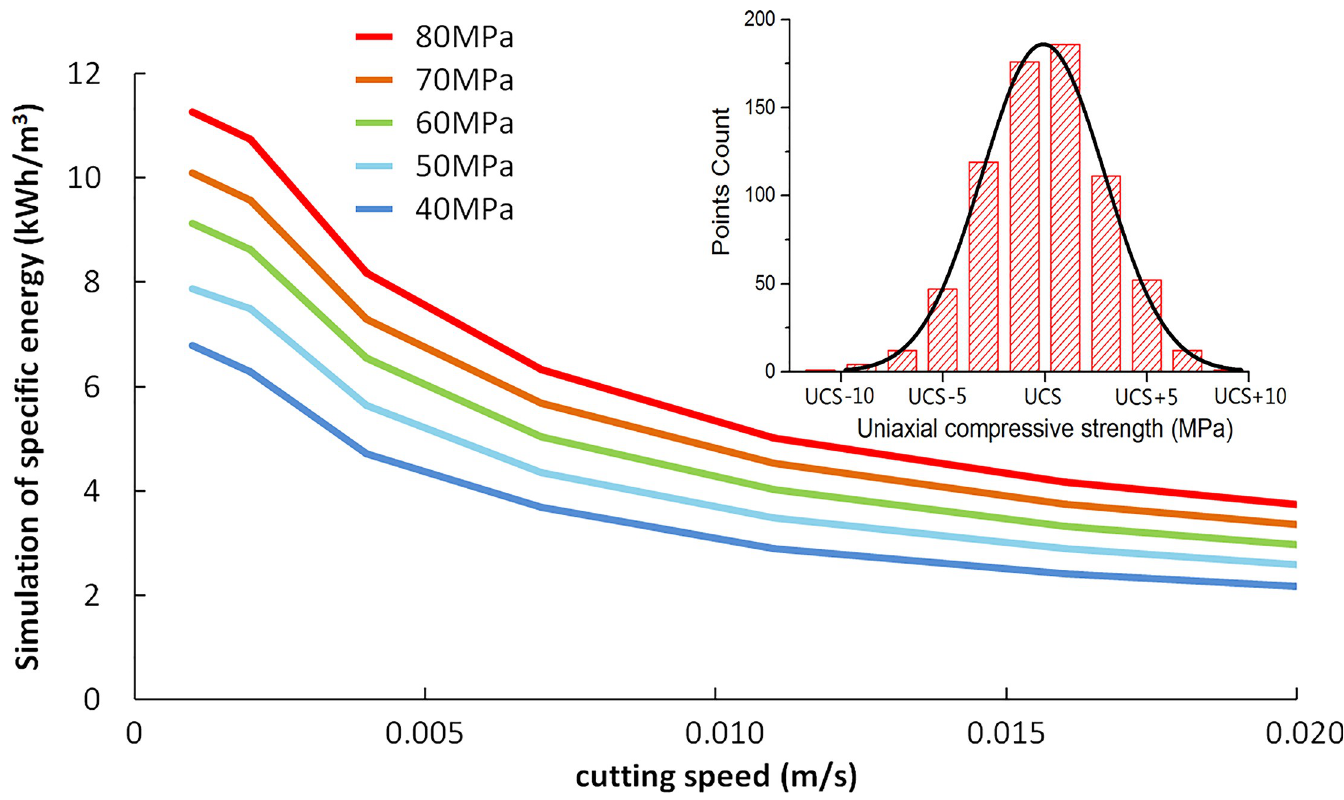
Fig 22. Calculation results of specific